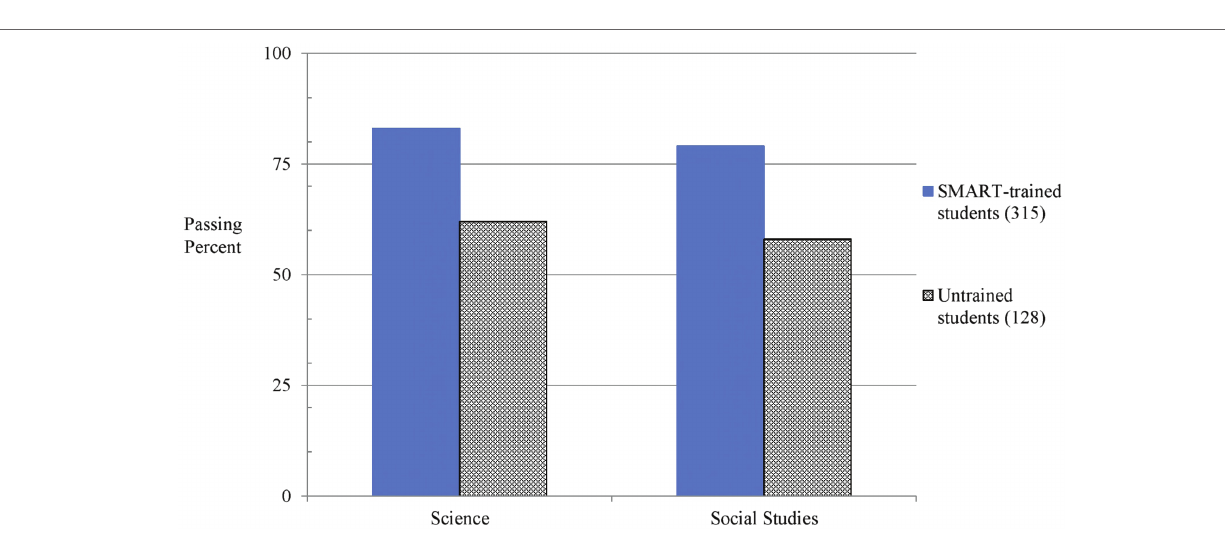
FIGURE 3 | Passing rates for eighth graders are shown for trained and untrained groups on the STAAR Science and Social Studies tests after training. On both tests, the trained group outperformed the untrained